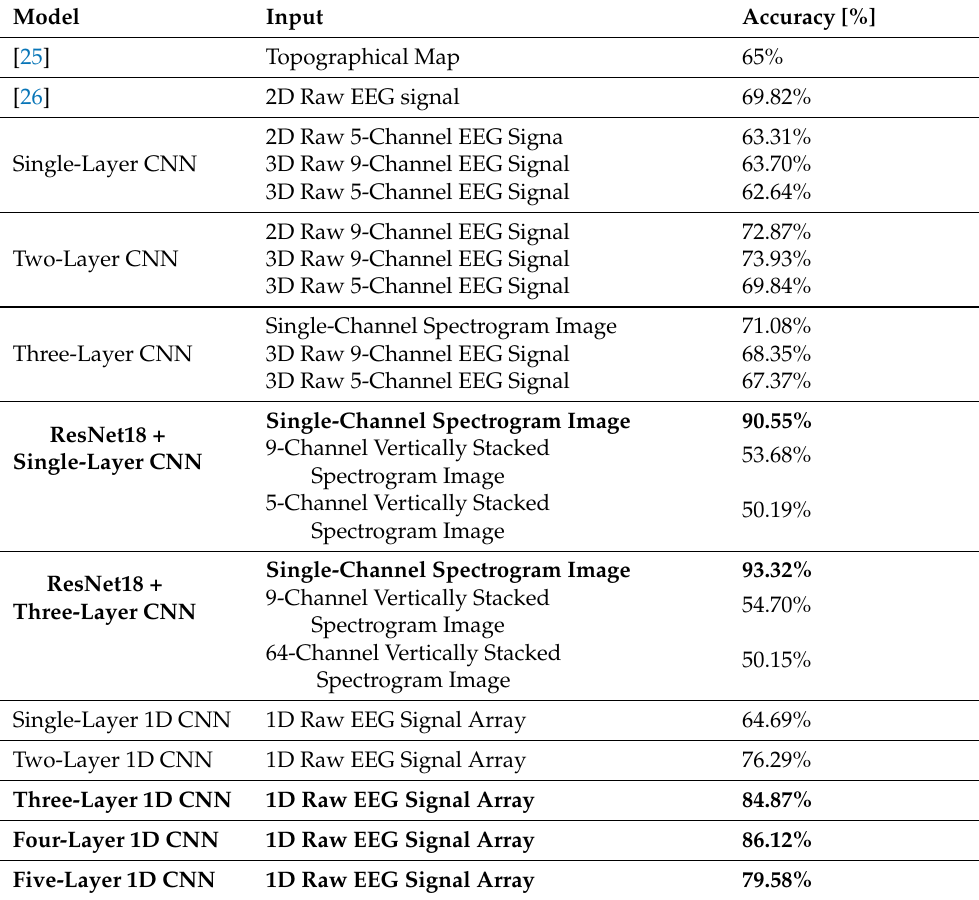
Table 6. Comparison of best results presented in this work in comparison with the studies from the state of the art. The three best results for each of the proposed models are presented. It can be observed that the highest accuracy scores were obtained through the single-channel spectrogram images as input for the transfer learning implementations, with scores higher than 90%. Nevertheless, promising results were obtained through the 1D representations of the signal with the 1D CNN models, with accuracies that were able to exceed an 80% accuracy performance. In contrast with the single-channel spectrogram images, these samples required significantly less time to prepare. Additionally, the 9- and 5-channel 2D and 3D representations of the signals provided promising results with the CNN models, with results that were able to outperform the state of the art. Further exploration of these forms of representations as input for DL models might yield promising results for the MI classification task. The best five results are highlighted with